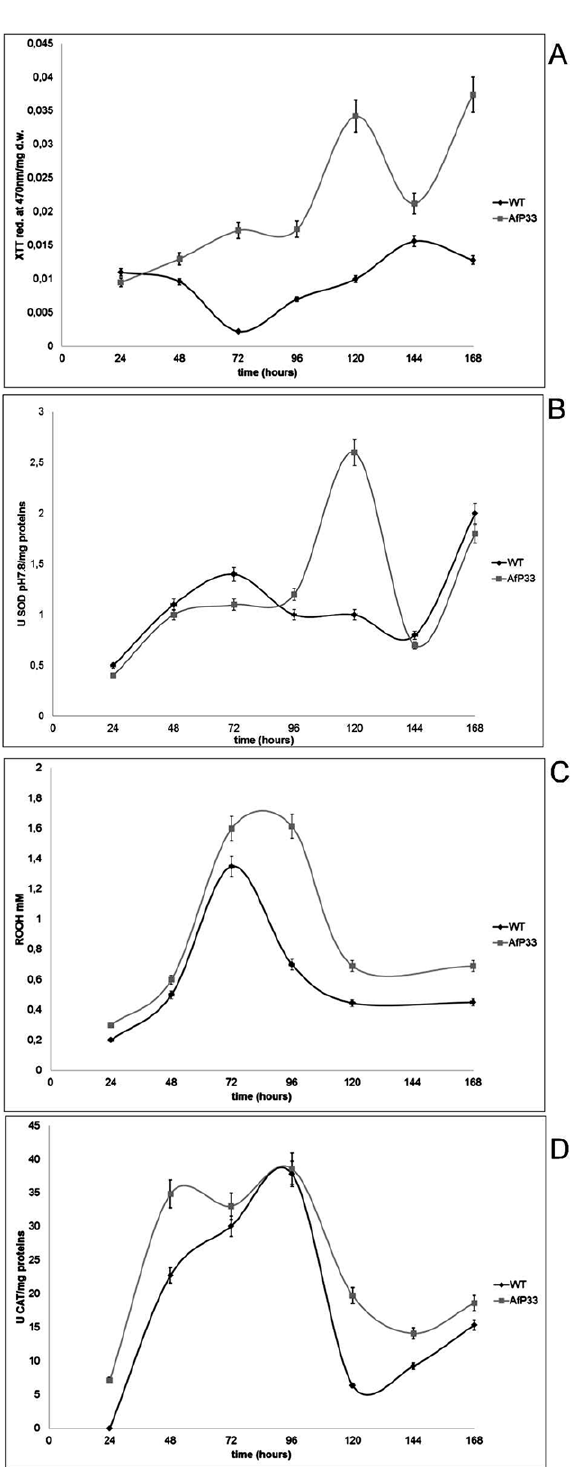
Figure 8. Reactive oxygen species formation and antioxidant enzyme activities. (A) Detection of superoxide anion formation (reported as absorbance of XTT formazan at 490nm/mg dry weight-d.w. mycelia), (B) SOD activity at pH 7.8 (U/mg proteins), (C) Peroxides (ROOH mM) and (D) CAT activity (U/mg protein) in mycelia of A. flavus WT and AfP33 strains grown in CD at different time intervals of incubation at 30 u C.